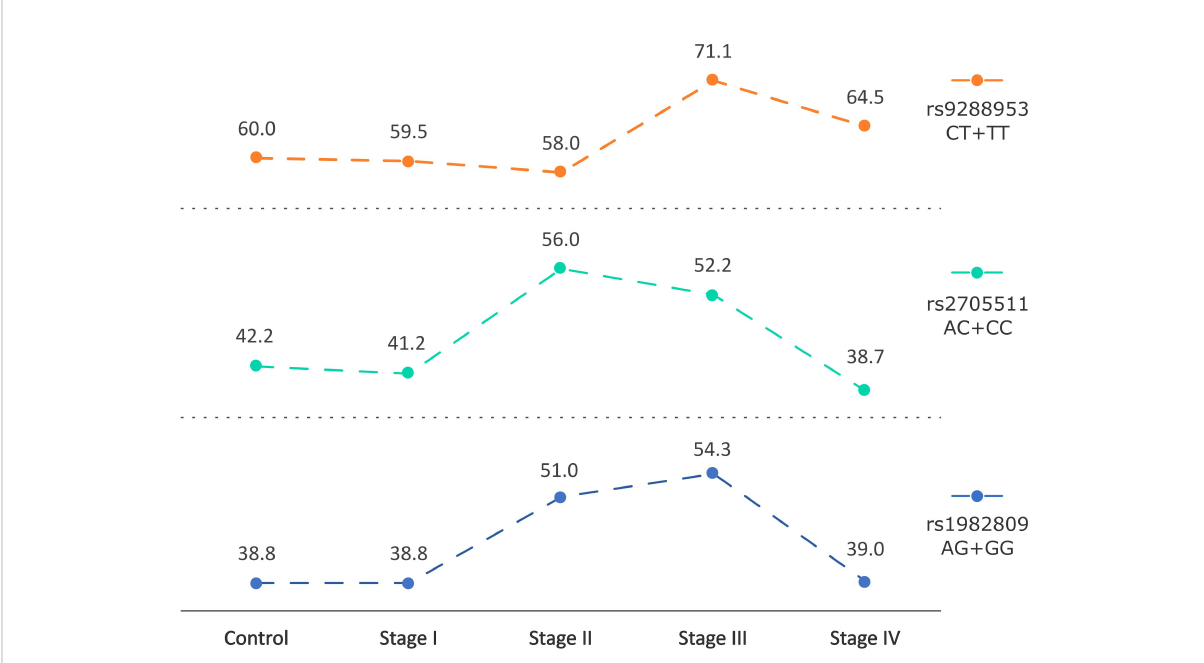
FIGURE 3 Changes in frequencies of rs2705511C, rs1982809G, and rs9288953T alleles carriers based on the stage of NSCLC. Points indicate % frequency of selected SNPs in the speci fi c stage of